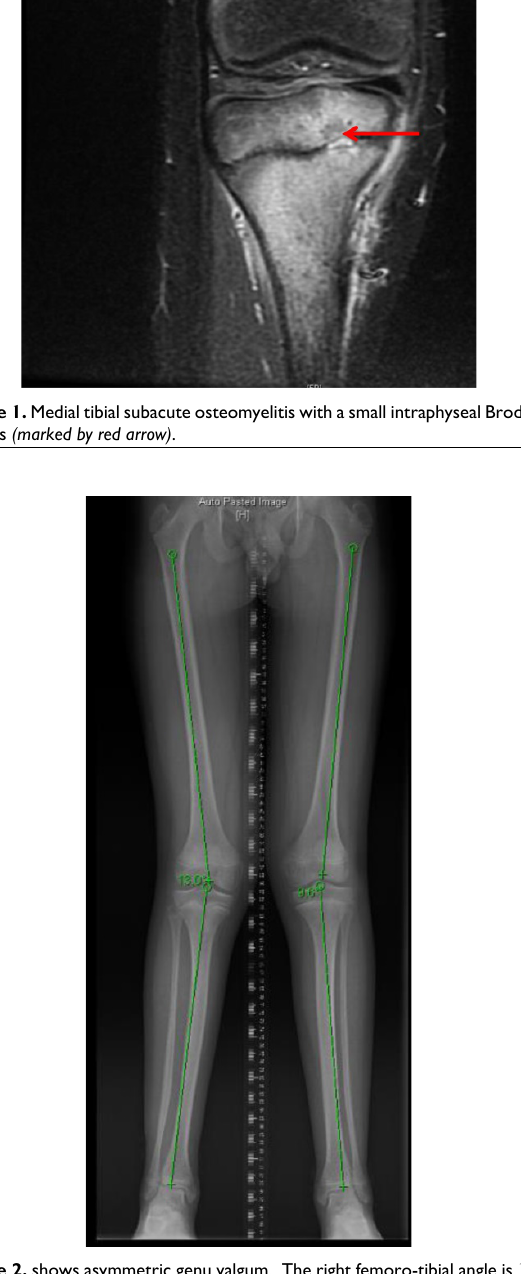
Figure 2. shows asymmetric genu valgum. The right femoro-tibial angle is 13°, the left femoro-tibial angle is